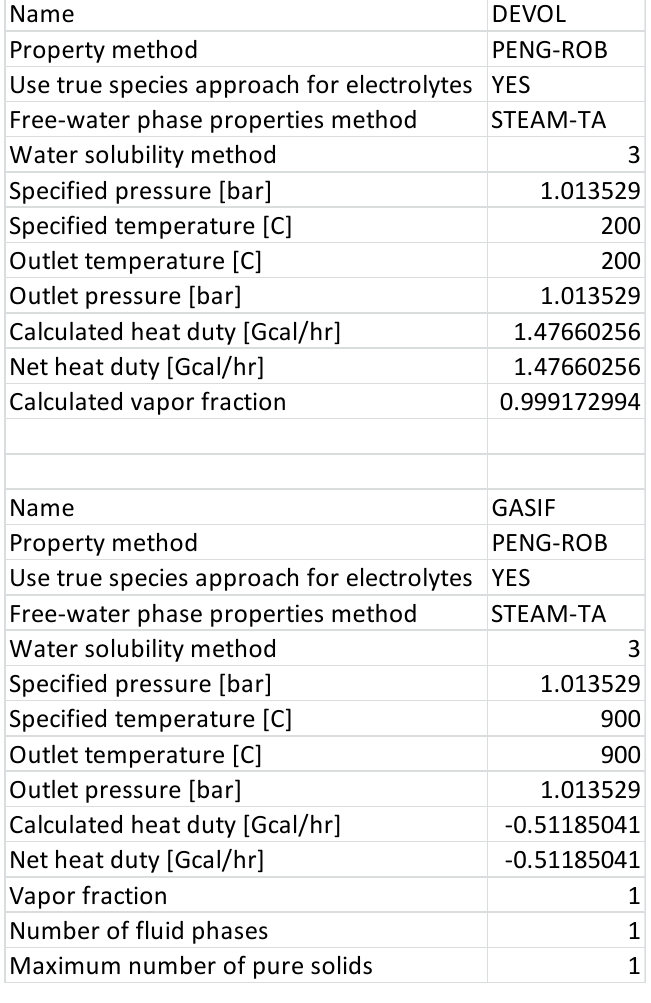
Figure A12. Gasification devol and gasif results.